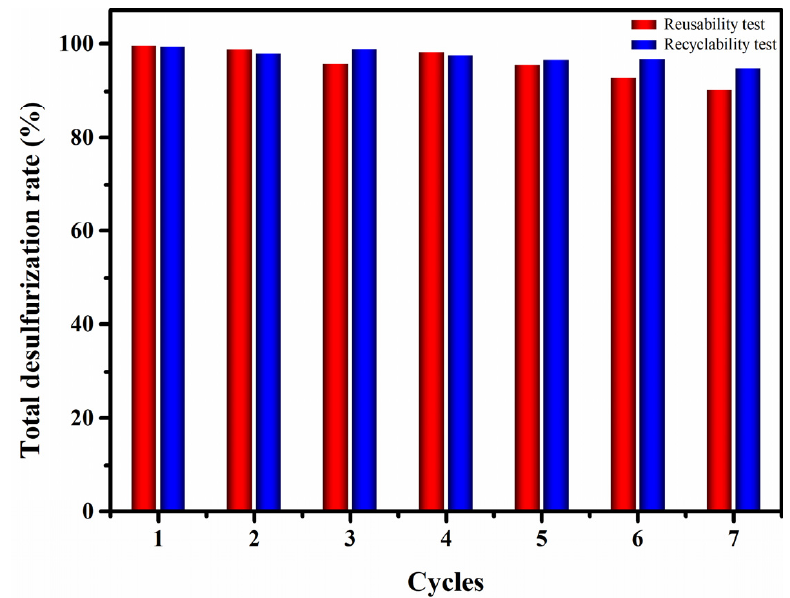
Figure 8. Reusability of catalyst PW 2 Mo 2 @HPMOS and recyclability of the EODS system.